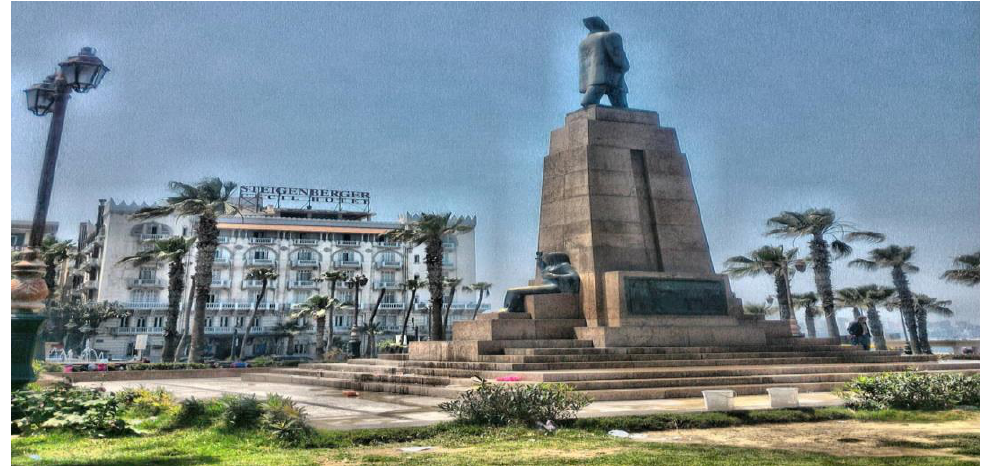
Figure 4: The Monument of Saad Zaghloul, Raml Station - Alexandria (Imgrum,